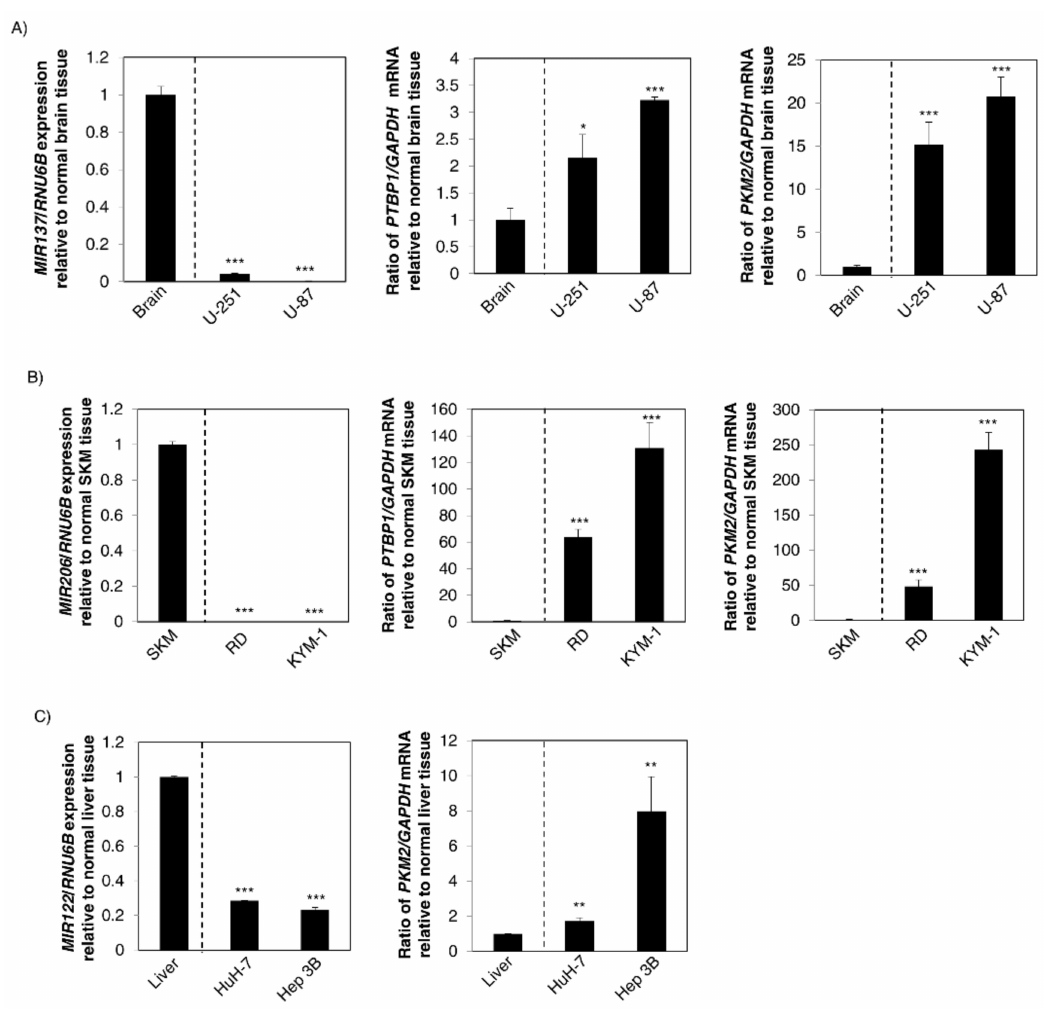
Figure 4. Downregulation of these organ-specific miRNAs contributed to carcinogenesis through upregulation of Warburg-effect-related genes. ( A ) Left panel: Expression levels of MIR137 in the normal human brain tissues and GBM cell lines; Middle panel: mRNA expression levels of PTBP1 in the same samples; Right panel: That of PKM2 mRNA expression; ( B ) Left panel: Expression levels of MIR206 in the normal human skeletal muscle tissues and RMS cell lines; Middle panel: The mRNA expression levels of PTBP1 in the same samples; Right panel: That of PKM2 mRNA expression; SKM: skeletal muscle; ( C ) Left panel: Expression levels of MIR122 in the normal human liver tissues and HCC cell lines; Right panel: mRNA expression levels of PKM2 in the same samples. Results are presented as the mean ± SD; * p < 0.05; ** p < 0.01; *** p <